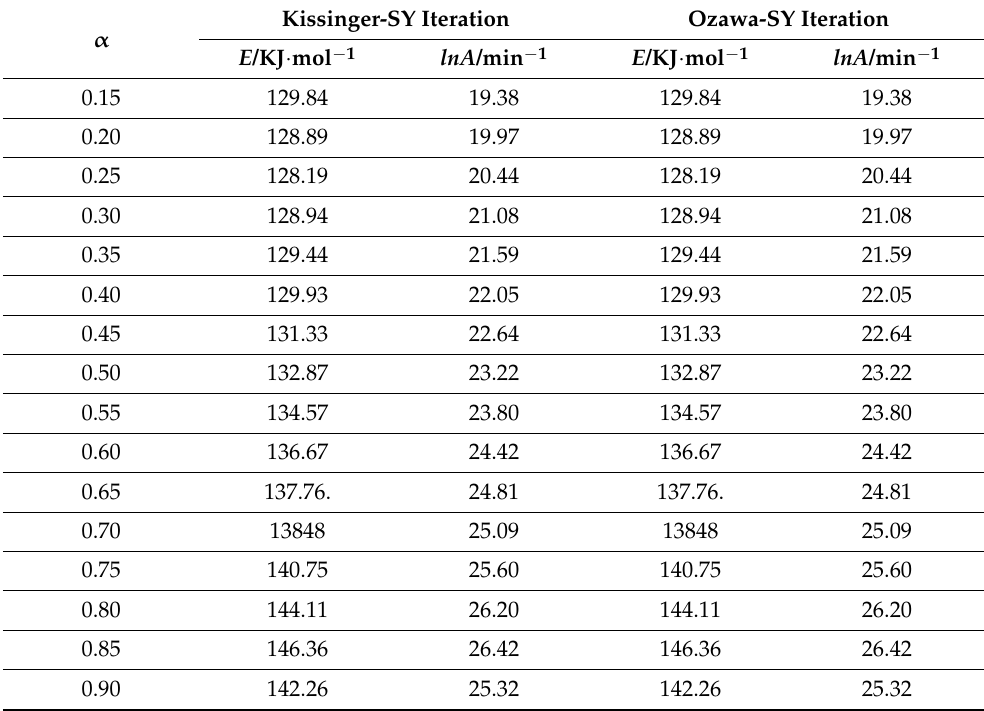
Table 7. Activation energy and preintential factors of EP/15% F-lignin@HKUST-1 at different conver- sions under Kissinger-SY iteration and Ozawa-SY iteration